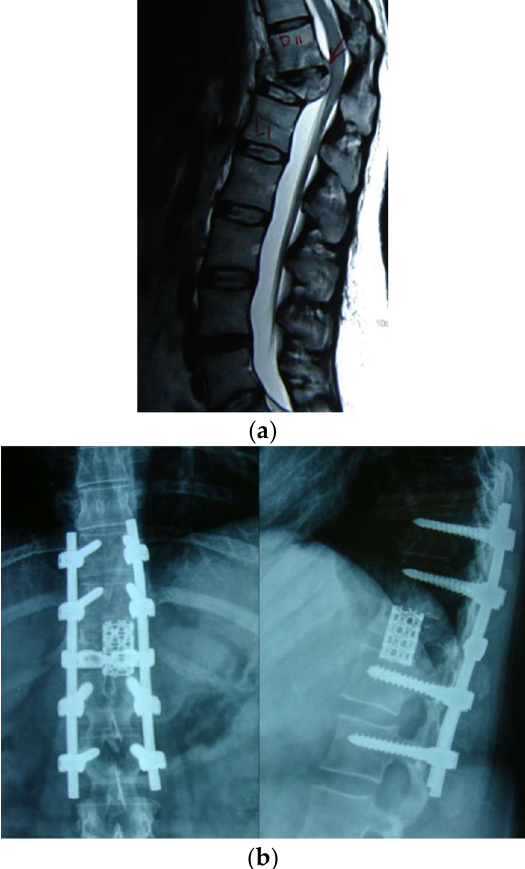
Figure 2. ( a ) Shows collapsed D12 vertebra with an abscess compressing the spinal cord; ( b ) shows front and back surgeries with anterior reconstruction, with a cylindrical mesh cage in addition to the posterior decompression and stabilization with pedicle